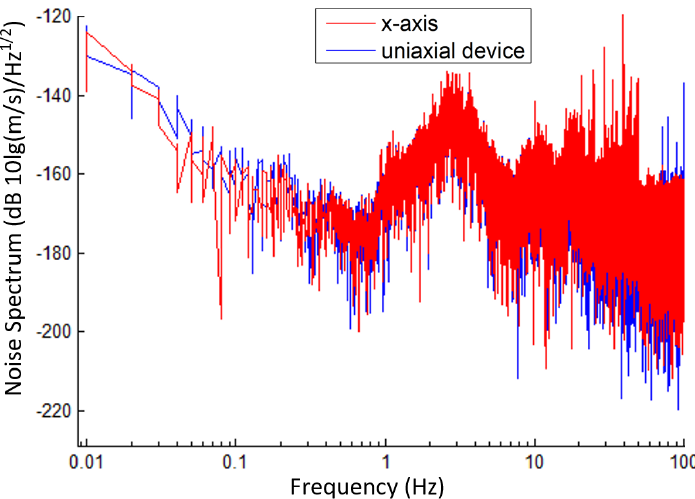
Figure 10. The noise power spectrum of the developed integrated triaxial electrochemical seismometer in comparison with the reference device.